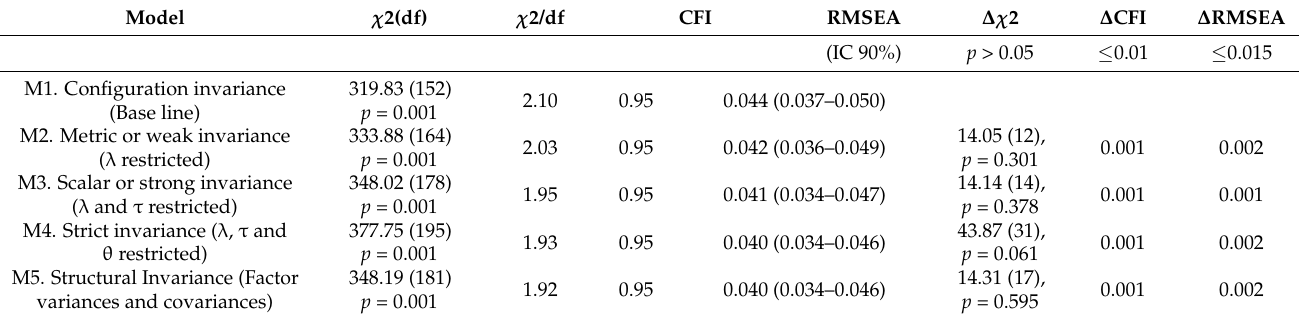
Table A4. Analysis of the factorial invariances for the girls model.